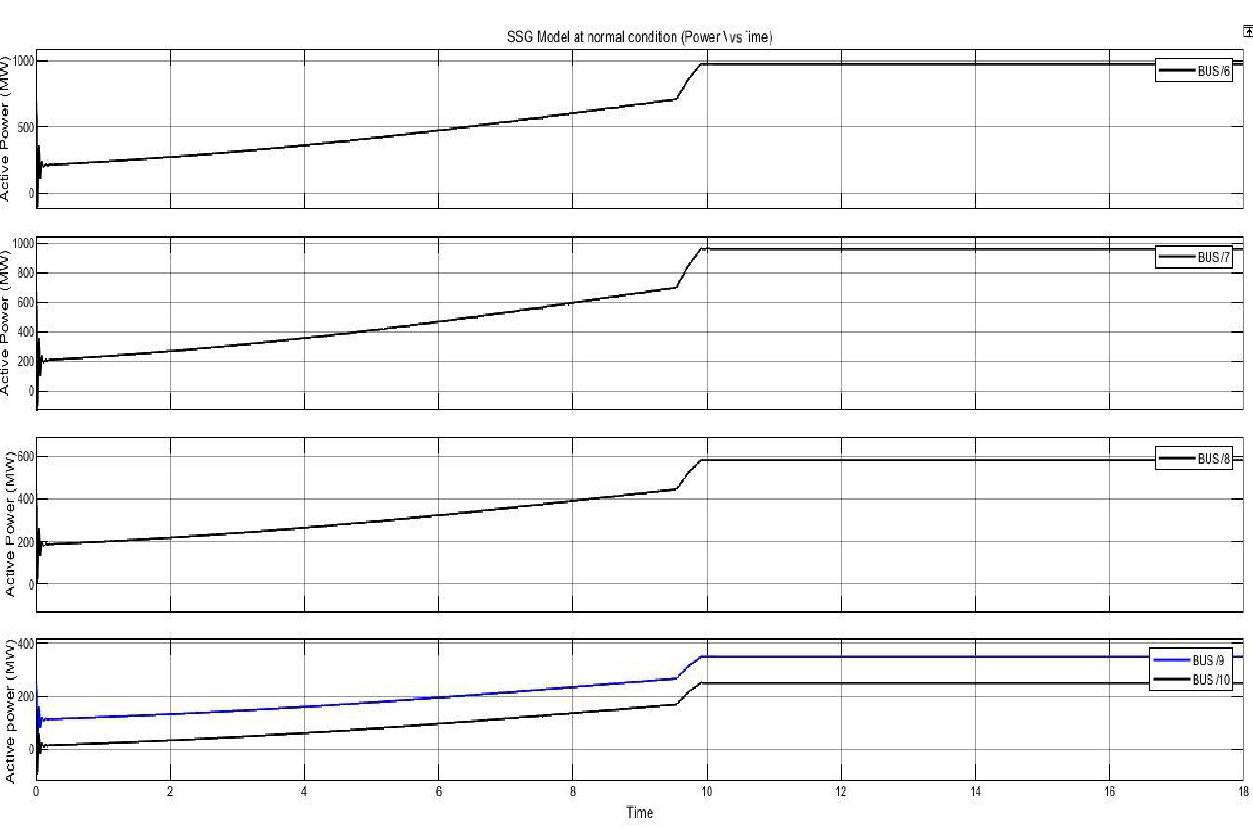
Figure 16. System in normal state, and no fault is introduced (Bus 1 to Bus 5).